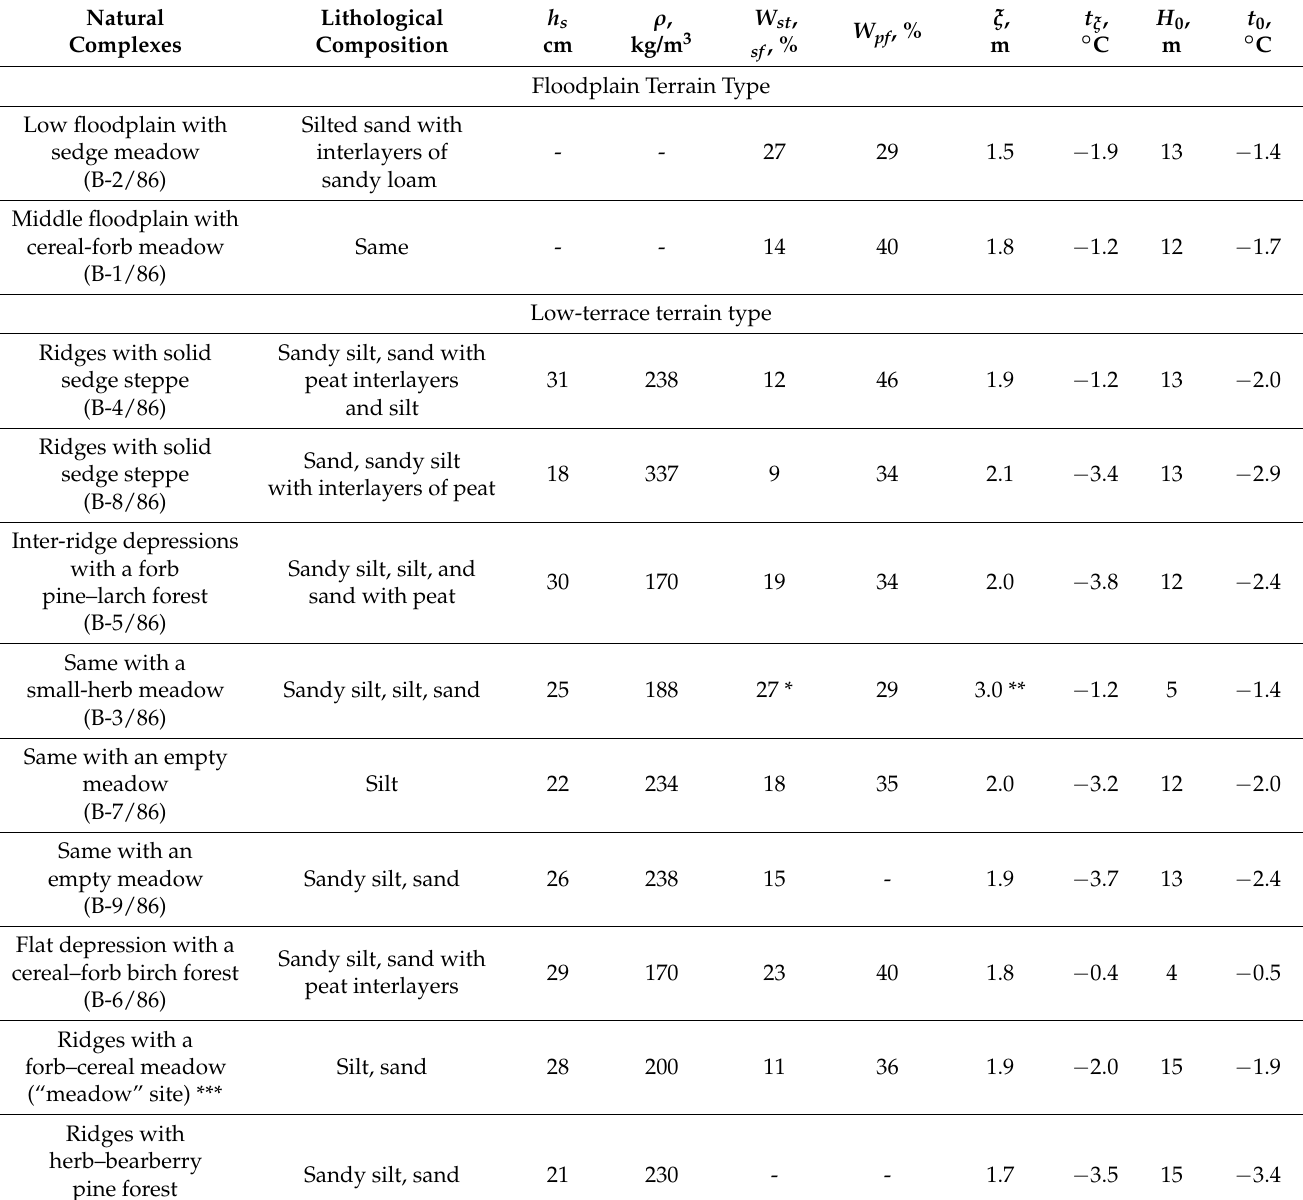
Table 2. Parameters of the ground thermal regime at floodplain and above floodplain–low-terraced terrain sites in October 1986– November 1987